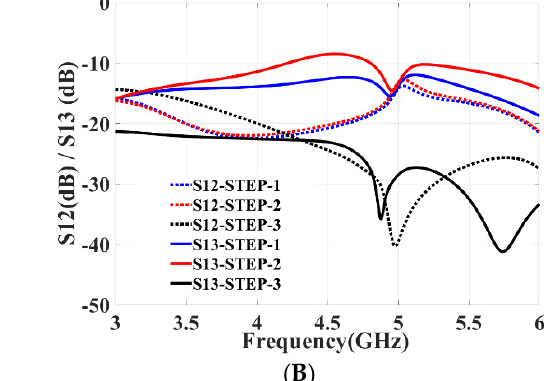
Figure 5. Frequency variation of S-parameters for different configuration: ( A ) S 11 [dB], and ( B ) S 13 [dB].